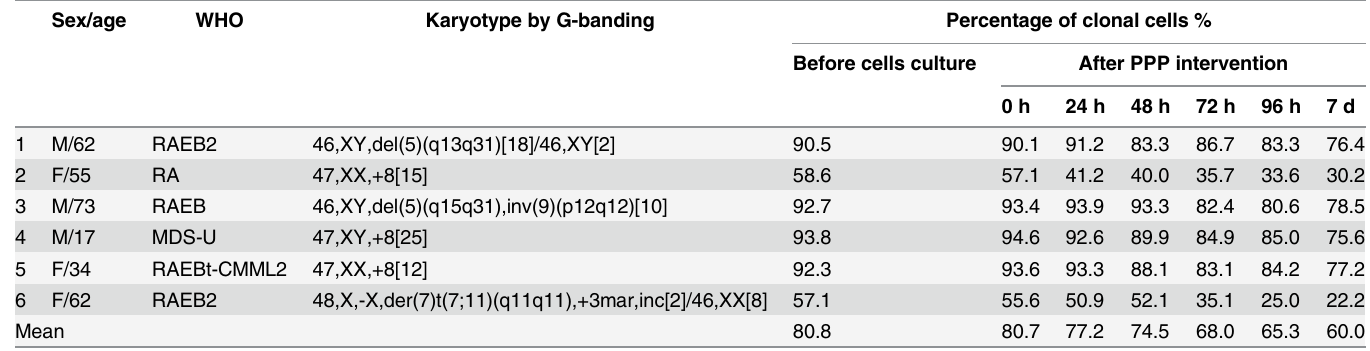
MDS is a clonal disease. Malignant clonal cells, which co-exist in bone marrow with normal hematopoietic cells in MDS patients, need to be selected for further study. Because MDS clonal Table 2. Changes in the percentages of clonal cells at different time points after PPP intervention in vitro . Sex/age WHO Karyotype by G-banding Percentage of clonal cells % Before cells